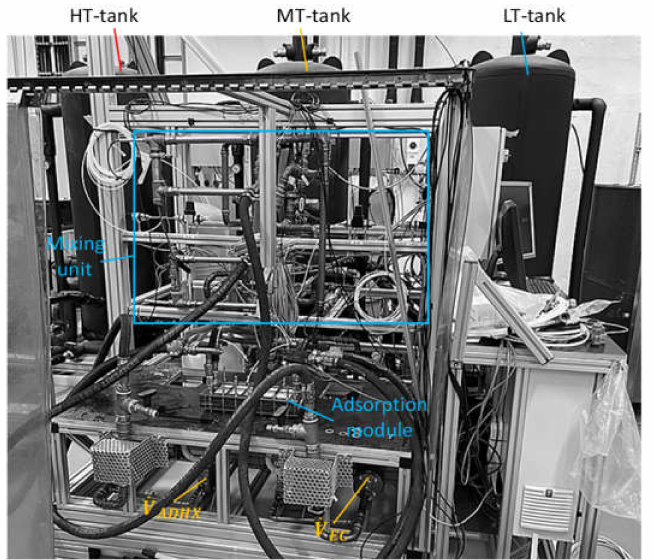
Figure 4. Test rig at Fraunhofer ISE with its three temperature level tanks (HT high temperature, MT medium temperature, LT low temperature), the mixing unit, and an adsorption module. The position of the volume flow rate sensors is additionally indicated. The temperature of the HTF is measured in closest proximity at the inlets and outlets of the adsorption